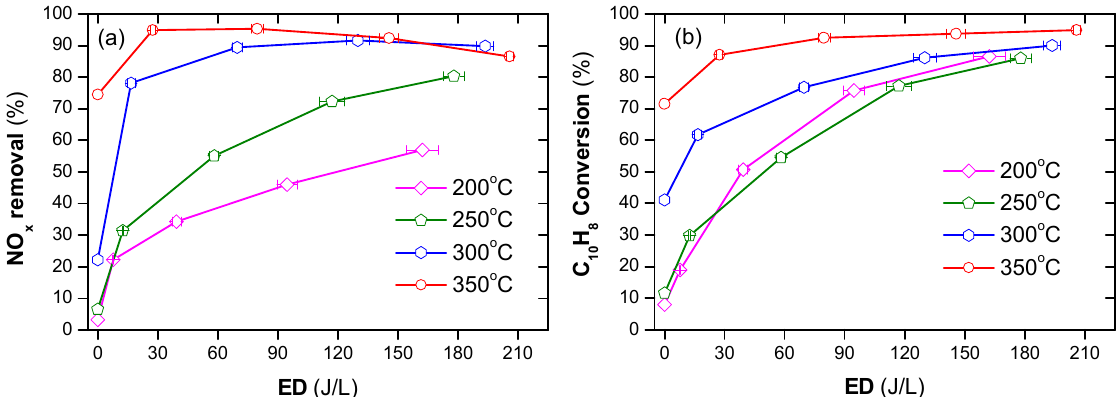
Figure 9. A plasma-catalyst process enhanced removal of NO x ( a ) and soot simulant ( b ) under the temperature from 200 °C to 350 °C with an ED from 0 to 210 J/L. It adapted from Reference [2].